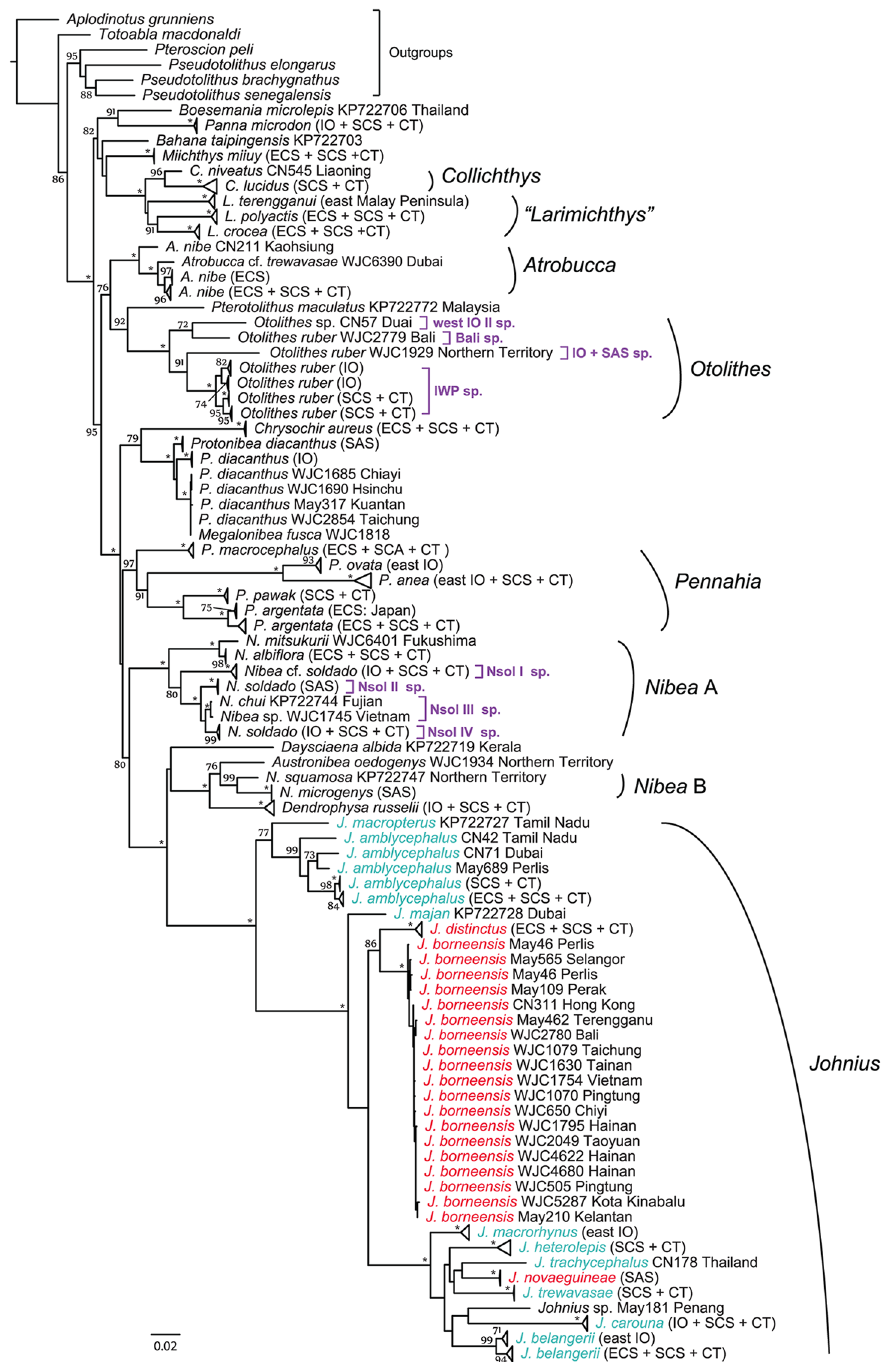
Fig 3. Phylogenetic tree of the IWP sciaenids inferred by partitioned maximum-likelihood method with GTR+ Γ + I nucleotide substitution model based on the combined dataset. Branch lengthsare proportional to the inferred nucleotide substitutions. Numbers at nodesrepresent bootstrapvalues in percentage. Values below70% are not shown; * indicates100%. Different colors in genus Johnius show that the taxa are either from the pre-recognized subgenus, Johnius (in blue) or subgenus Johnieops (in red). The tree is rooted with Aplodinotusgrunniens accordingthe result shown in Lo et al. [24]. Abbreviations for geographicdistributionof the taxa: IO, Indian Ocean; ECS, East China Sea; SCS, South ChinaSea; CT, Coral Triangleregion; SAS, Sahul Shelf and Australia.